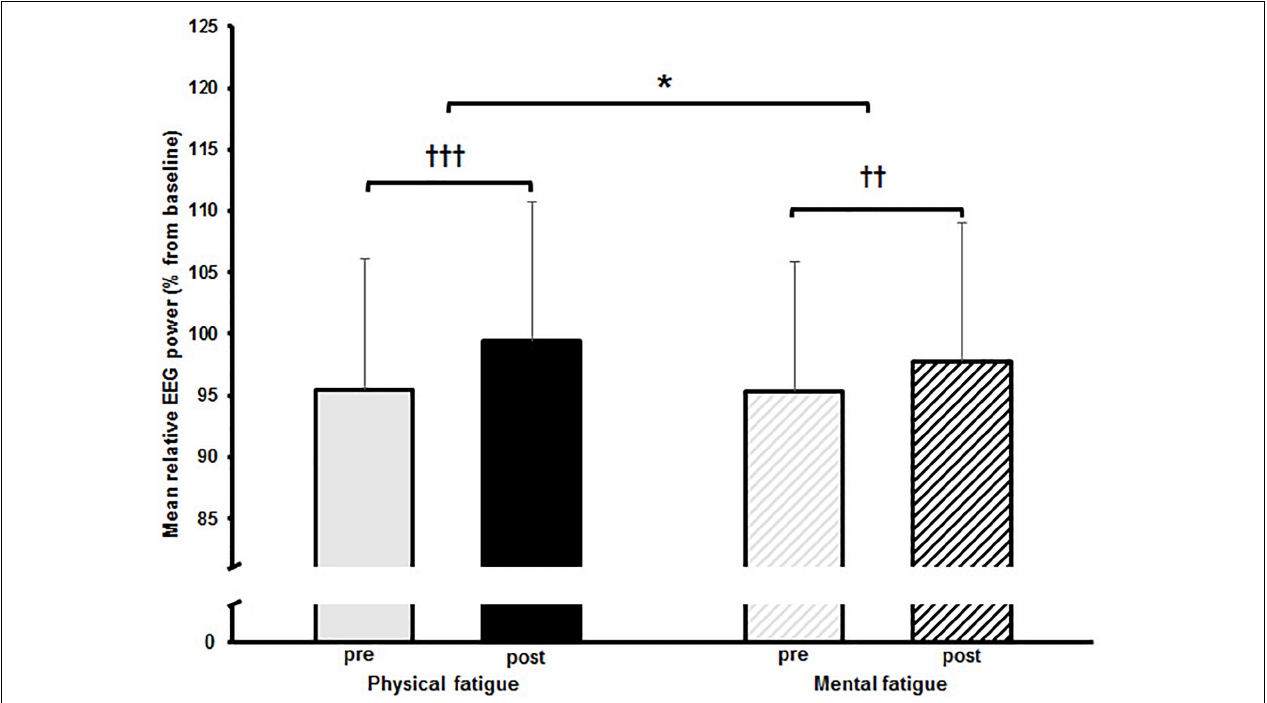
FIGURE 5 | Mean relative alpha-2 frequency band power with standard deviation pre and post to physical and mental fatigue calculated from the electroencephalographic (EEG) electrodes located within the parietal region of interest. The significant interaction effect is indicated by; * p < 0.05. Post hoc results are indicated by; †† p < 0.01, ††† p <